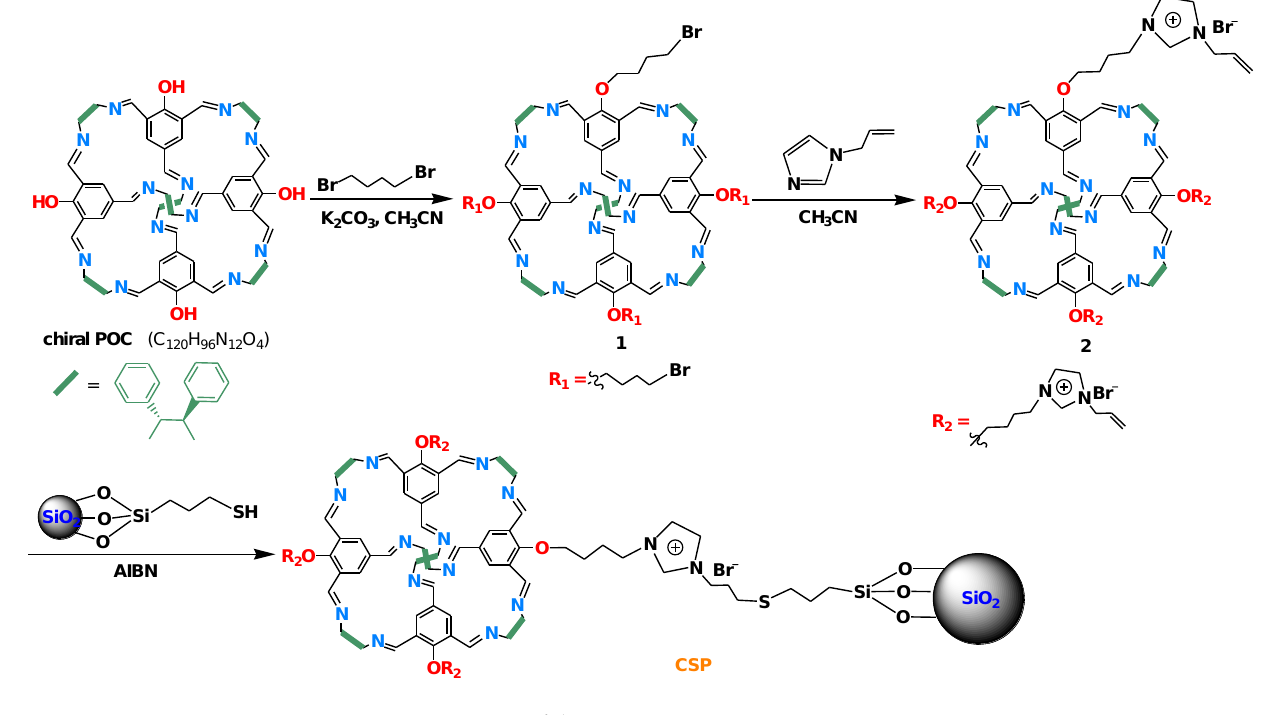
Figure 9. Preparation of the CSP.